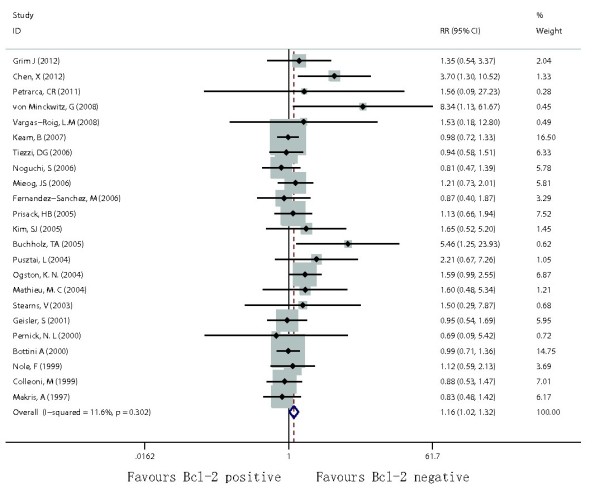
Forest plots of RR were assessed for association between Bcl-2 and total OR among breast cancer patients treated with chemotherapy.